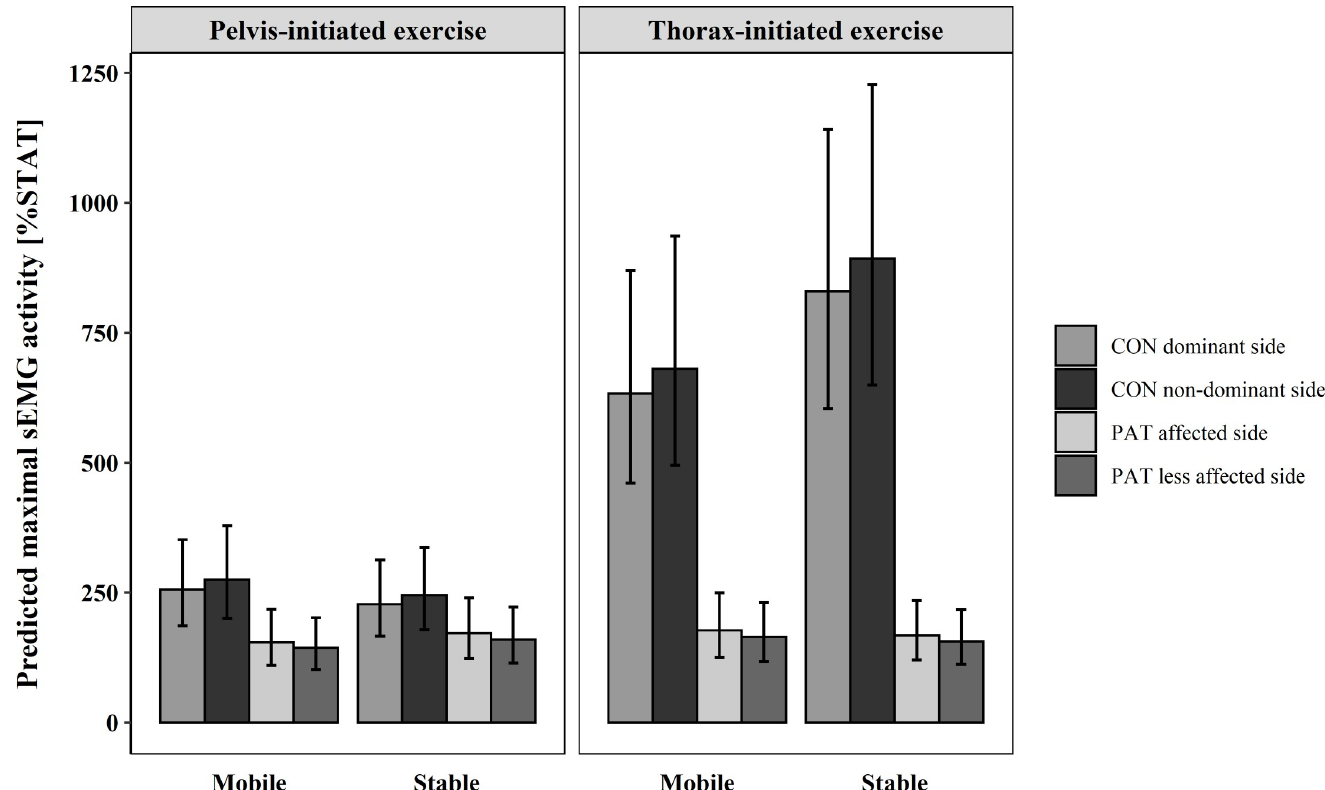
Fig 5. Predicted maximal sEMG activity and confidence level of each subgroup in M. obliquus externus. CON = healthy participants, PAT = people after stroke, %STAT = percentage of maximal muscle activity relative to static sitting on the stable seat.